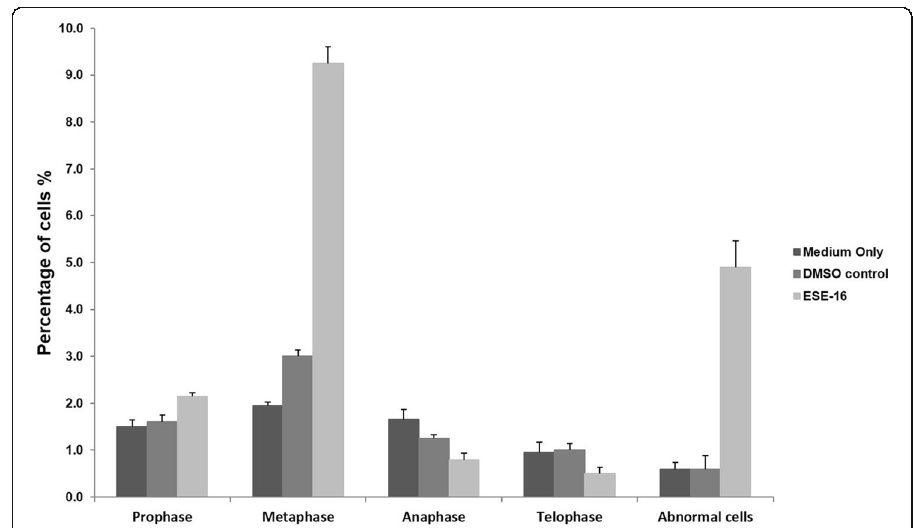
Fig. 5 Bar graph indicating the mitotic indices of HeLa cells propagated in medium or DMSO with or without ESE-16 exposure. Cells treated with ESE-16 demonstrated increased numbers in metaphase and apoptotic hallmarks when compared to the controls